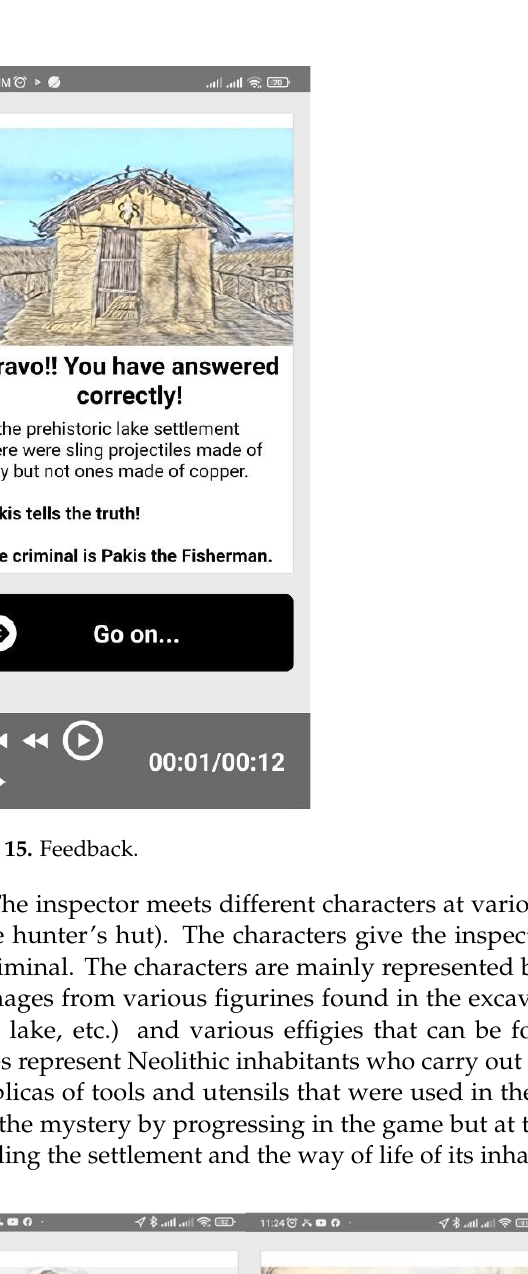
Figure 14. Question for the player.